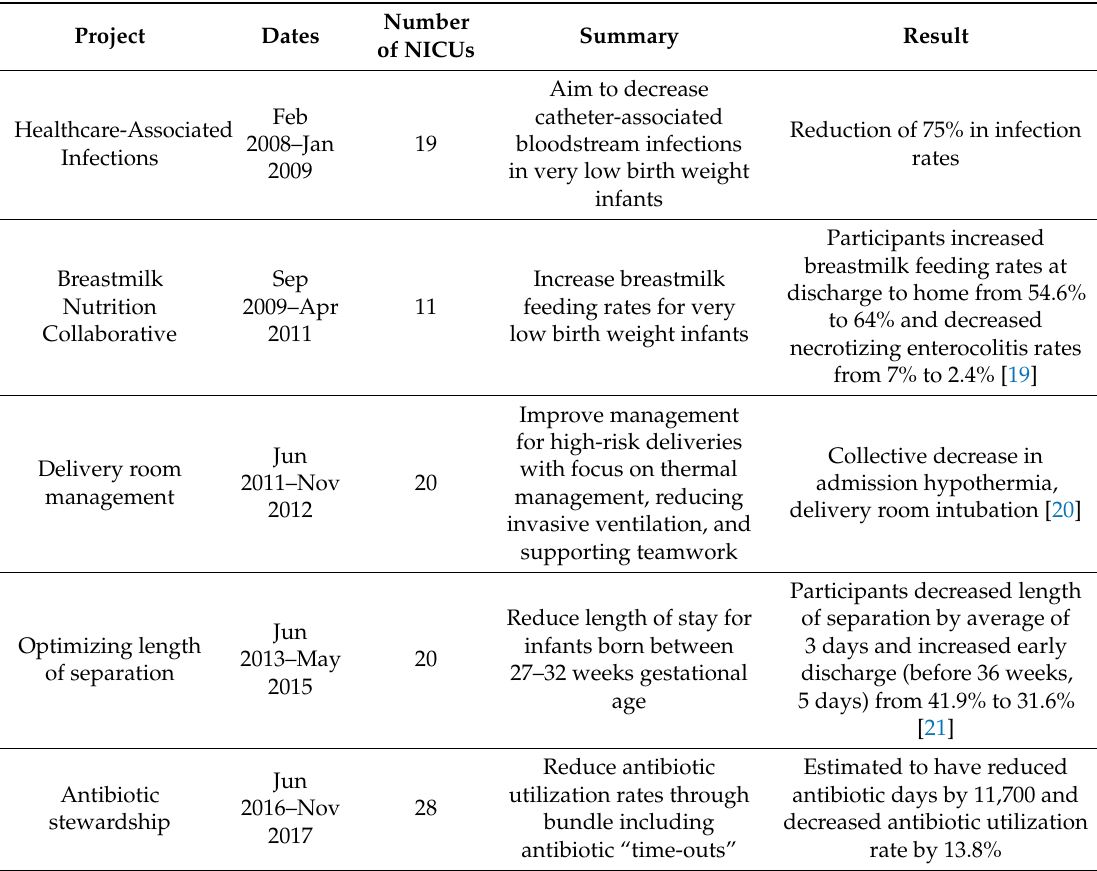
Table 2. CPQCC Quality Improvement (QI) collaborative projects based on the Institute for Healthcare Improvement (IHI) Model for